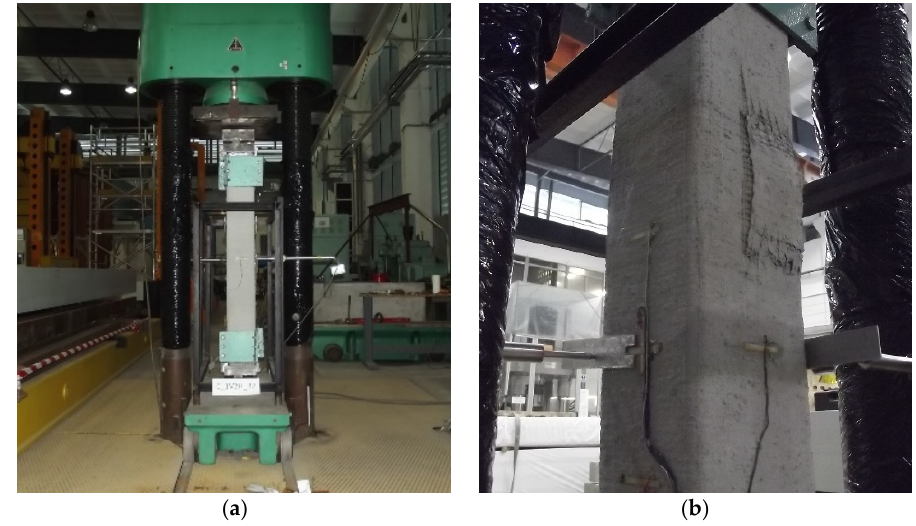
Figure 6. C_1V2H_32 specimen on test stand. ( a ) test setup; ( b ) failure of column